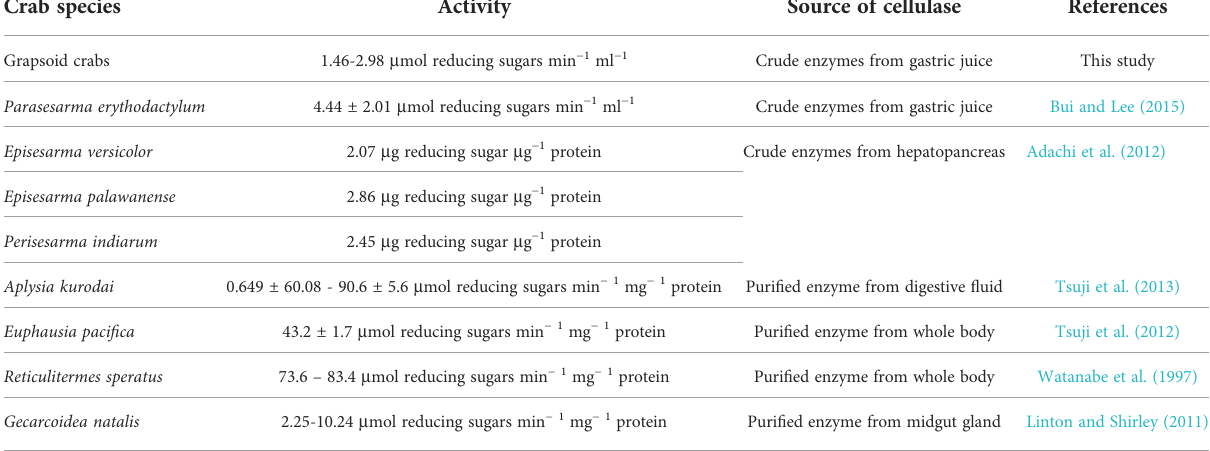
TABLE 7 List of EG activities of various organisms. Crab species